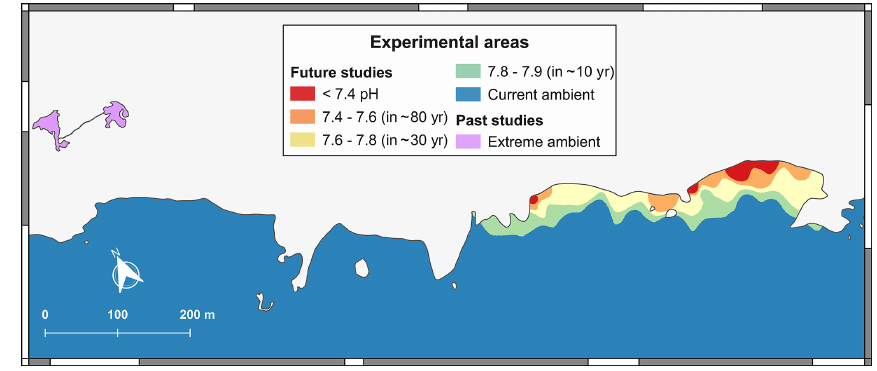
Figure 6. Selected areas for experimental purpose (Interpolation IDW, 4.0 of correlation with